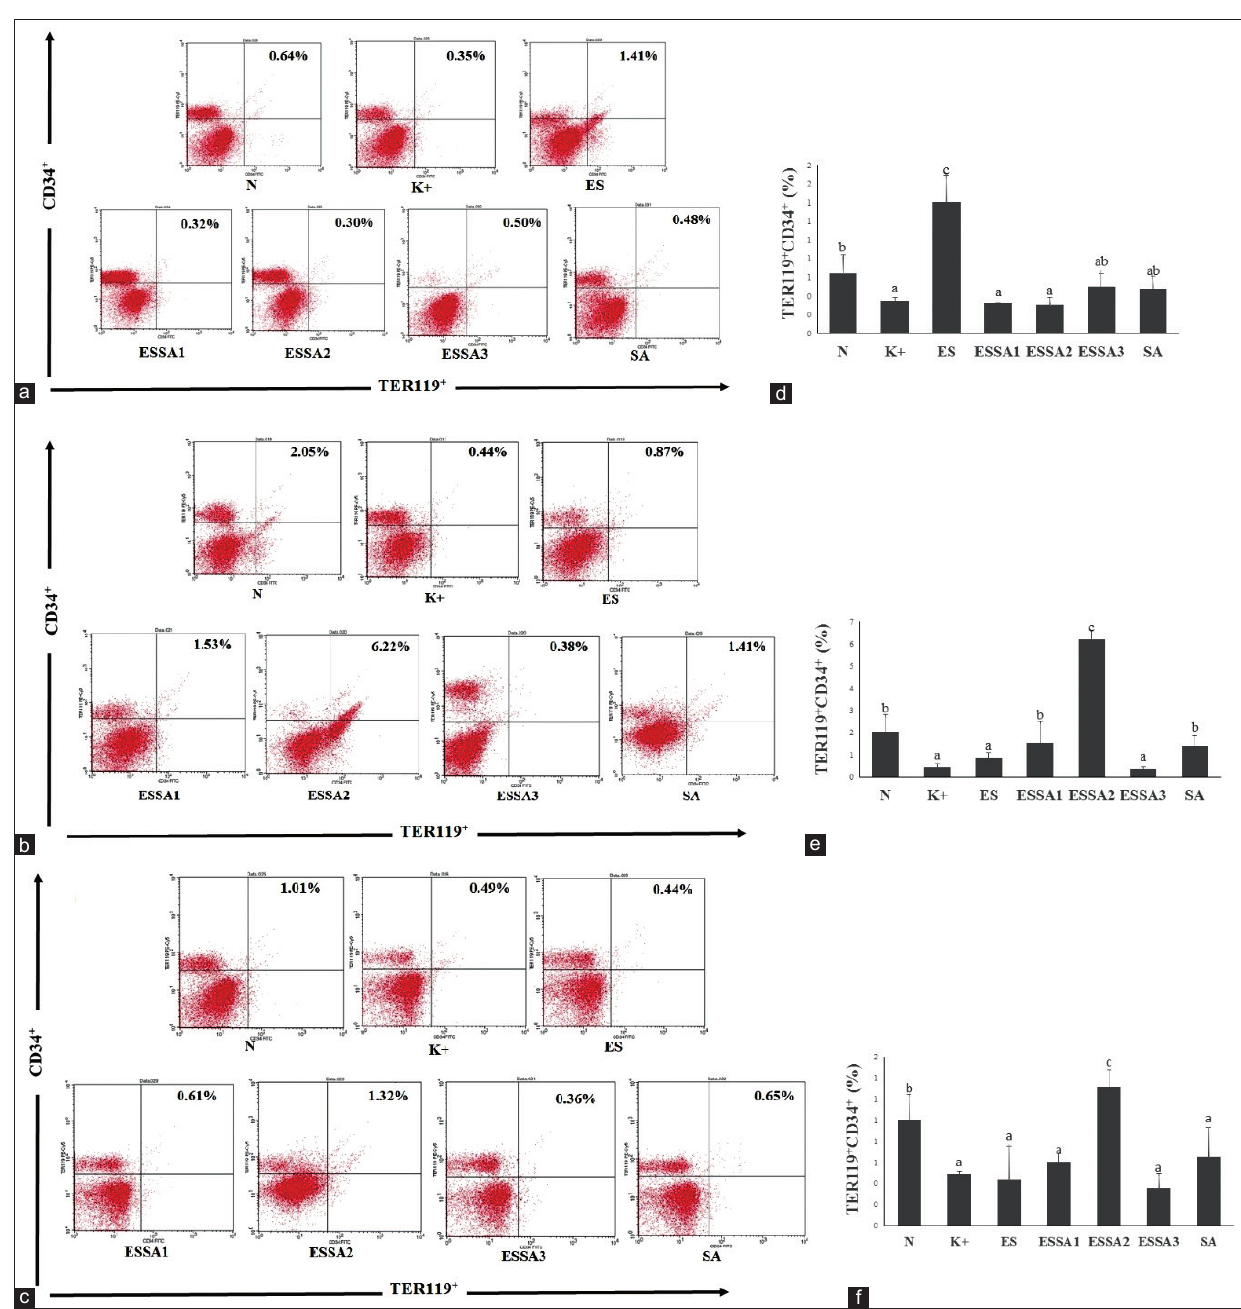
Figure-2: Flow cytometry of isolated bone marrow labeled with TER-119 + CD34 + post-Escherichia coli challenge. (a-c) Representative FACS dot plots showing the percentage of TER-119 + CD34 + in all groups treatment on day-8, 12, and 16, respectively. (d-f) The bars are a calculation of the relative number TER-119 + CD34 + expression on day-8, 12, and 16, respectively. The results were expressed as the mean±SD. Different superscript letters indicate statistical significance (p<0.05). Note: Healthy pregnant mice were not subjected to E. coli infection (N), pregnant mice infected with E. coli (K+), pregnant mice infected with E. coli and treated with 200 mg/kg of ES (ES), pregnant mice infected with E. coli and treated with combined 150 mg/kg ES and 37.5 mg/kg SA (75% ES:25% SA), 100 mg/kg ES and 75 mg/kg SA (50% ES:50% SA), and 50 mg/kg ES and 112.5 mg/kg SA (25% ES:75% SA) (ESSA1, ESSA2, and ESSA3, respectively), and pregnant mice infected with E. coli and treated with 150 mg/kg SA